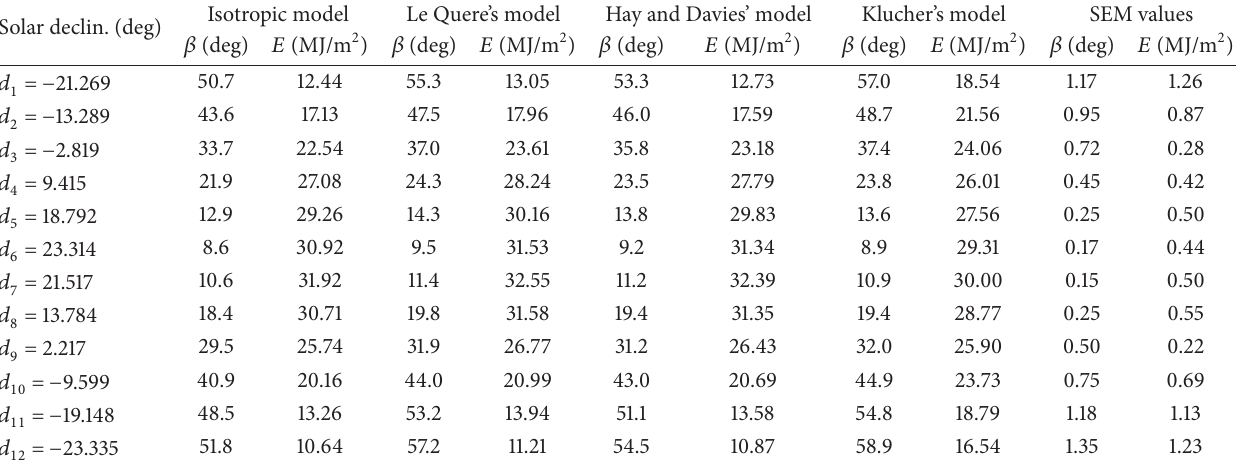
Table 1: Optimum tilt angle values and monthly mean of the daily global solar radiation values computed by means of the algorithm proposed in Section 2 applied to the monthly averages of the daily global horizontal solar irradiation data acquired from 1985 to 1989 at the site of Tripoli (latitude +32 ∘ 57 󸀠 N; longitude +13 ∘ 12 󸀠 E).